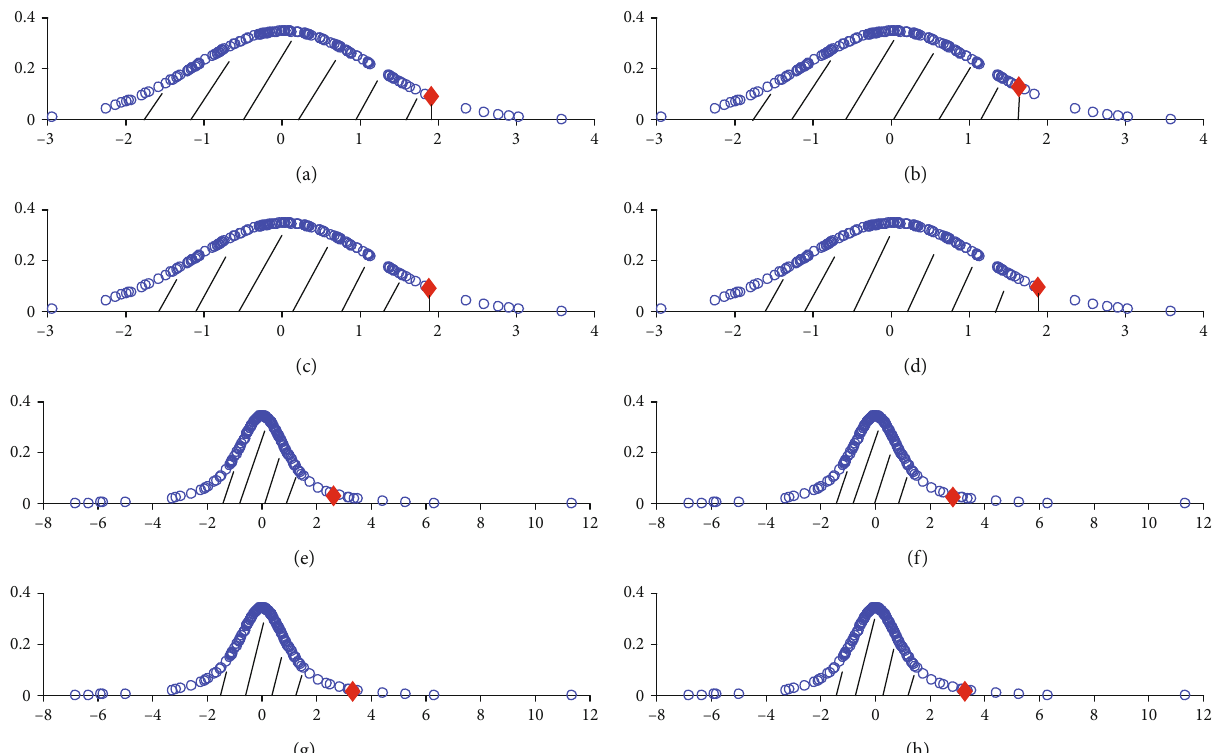
Figure 2: The corresponding probability function-based visualization of calculation for the VaR forecast of normal and t distributions; the red dot mark in the fi gure shows the “ position ” of the VaR forecast (to x -axis) and its corresponding ( 1 − α ) (under the